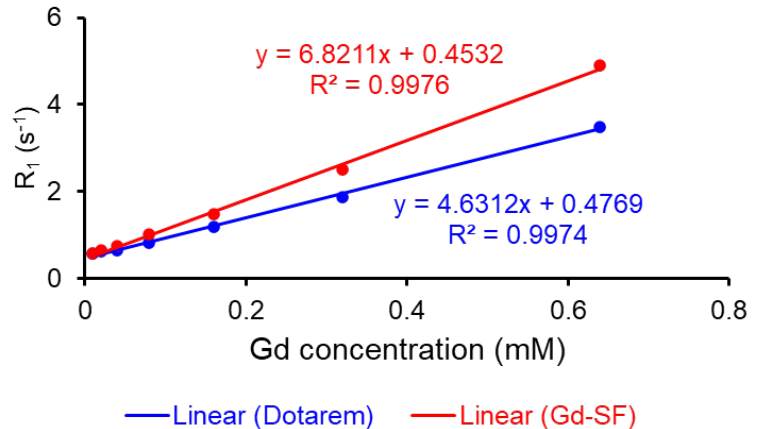
Figure 3. Plots of relaxation rate as a function of gadolinium concentration (0.01, 0.02, 0.04, 0.08, 0.16, 0.32, and 0.64 mM Gd). The slopes correspond to the molar longitudinal relaxivity (r 1 ) of Dotarem (r 1 = 4.63 mM − 1 s − 1 ) and Gd-DOTA-click-SF (r 1 = 6.82 mM − 1 s − 1 ) obtained using the inversion recovery method at 9.4 T. Table 1. In vitro relaxivity values at 3.0 T, 22.3 °C and 9.4 T, 19 °C for Dotarem and Gd-DOTA-click- SF (Gd-SF).